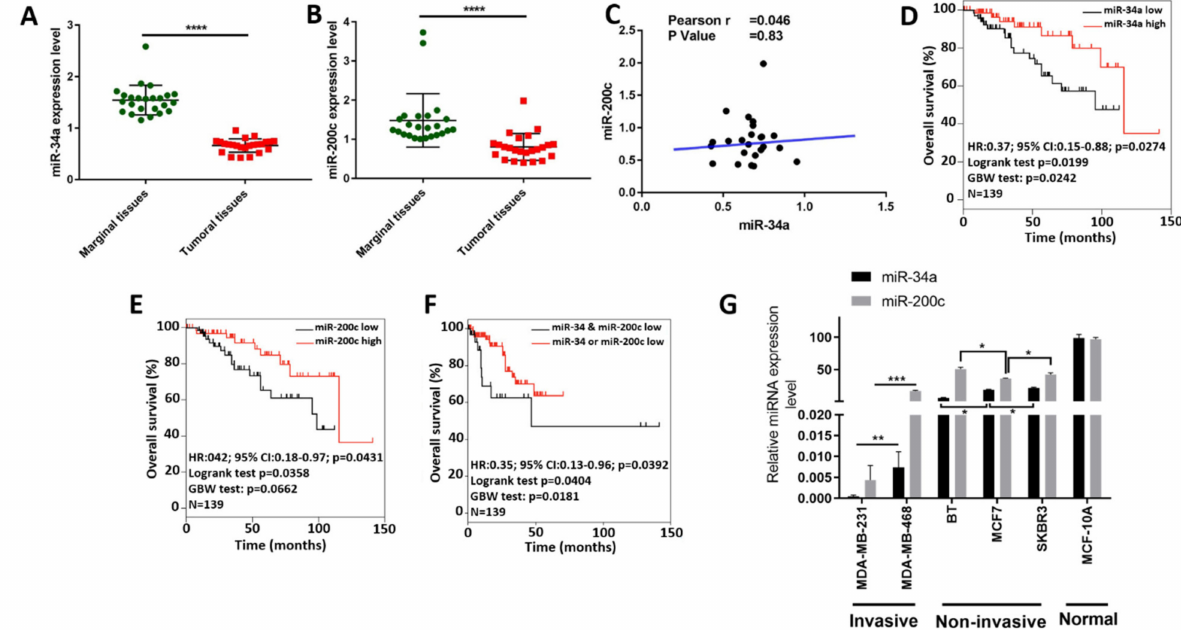
Figure 1. Downregulation of miR-34a and miR-200c is associated with breast cancer development. ( A , B ) Expression levels of miR-34a ( A ) and miR-200c ( B ) in breast cancer ( B , C ) and adjacent normal tissues, as determined by qRT-PCR. ****, p -value < 0.0001. ( C ) Pearson correlation analysis between miR-34a and miR-200c expression levels. ( D , E ) Overall survival curves for ER- breast cancer patients comparing patients whose tumors express high and low levels of miR-34a and miR-200c, respectively, using the median expression as the cut-off. HR: Hazard ratio; CI: confidence interval; GBW: Gehan-Breslow–Wilcoxon. ( F ) Overall survival curves as in ( D , E ), but here comparing patients whose tumors express both low miR-34a and low miR-200c to those expressing either low miR-34a or low miR-200c (using median cut-offs). ( G ) Expression levels of miR-34a and miR-200c in different invasive (MDA-MB-231 and MDA-MB-468), non-invasive BC cell lines (BT, MCF-7 and SKBR3) and normal breast cell line (MCF-10A), as determined by qRT-PCR. Abbreviations: *, p -value < 0.05; **, p -value < 0.01; ***, p -value <